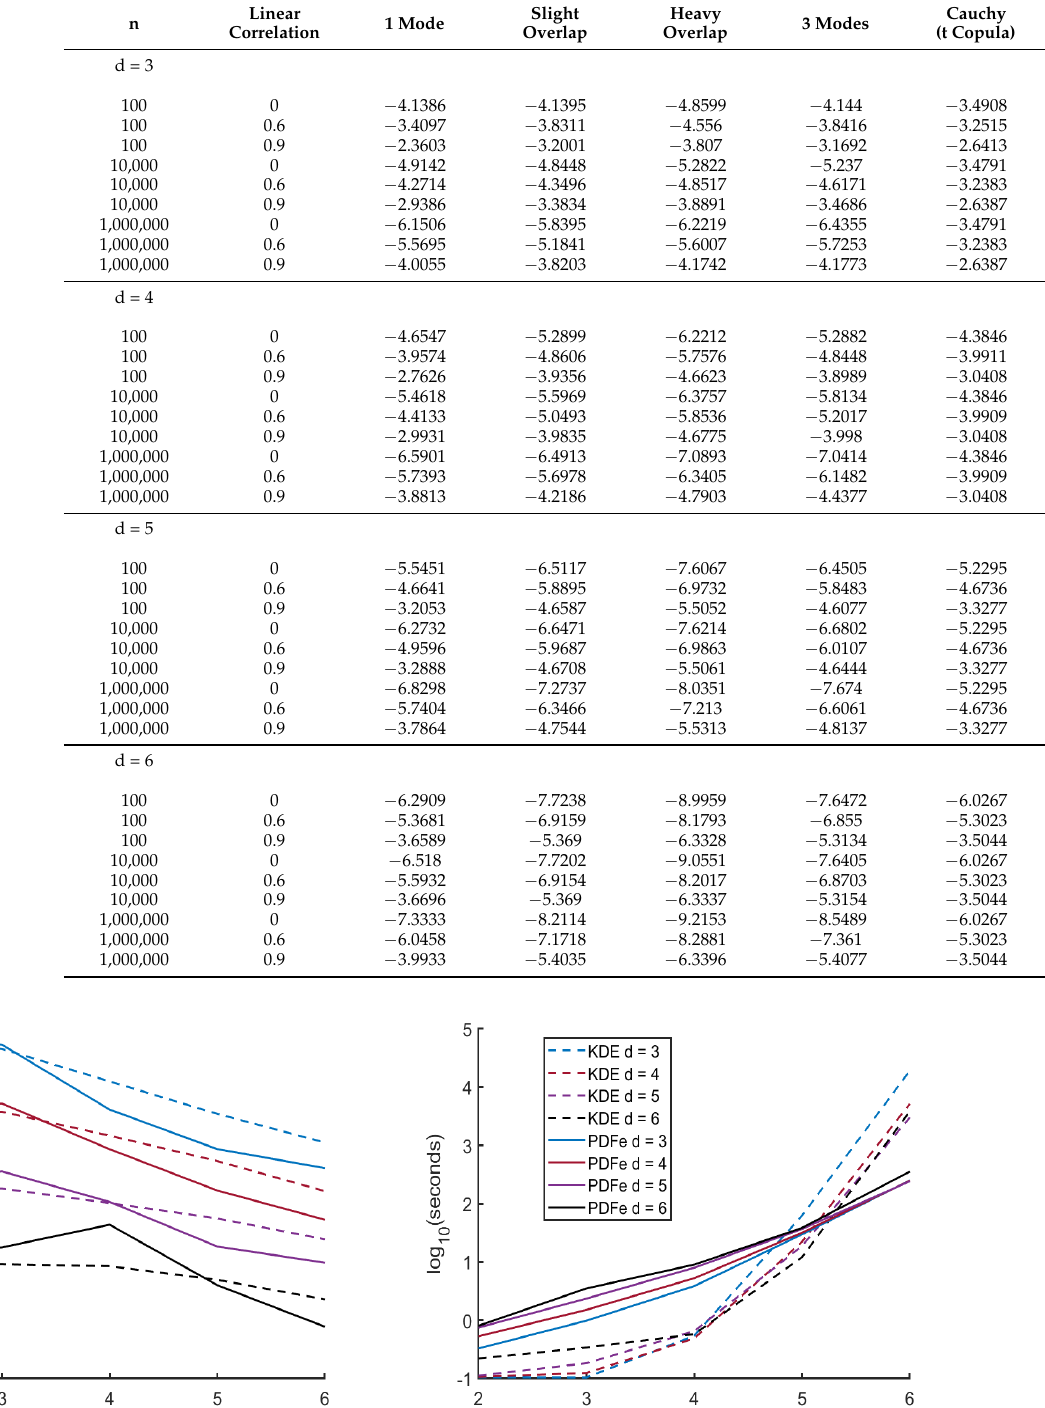
Table 4. Synthetic data accuracy using KDE based on MSE on a log base 10 scale.